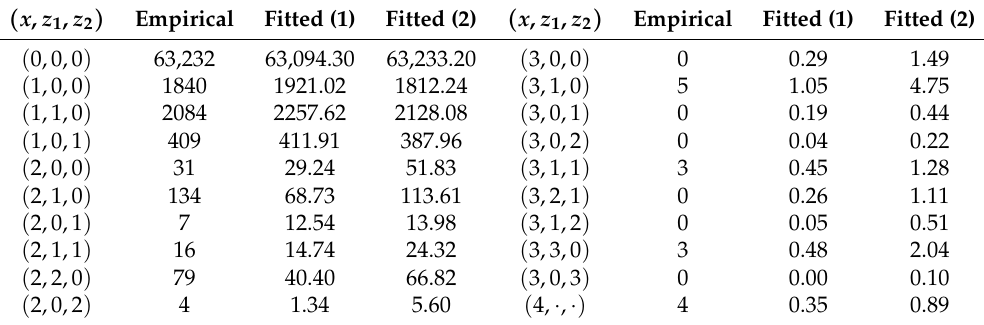
Table 2. Empirical and fitted data for the basic model (1) and mixture model (2).